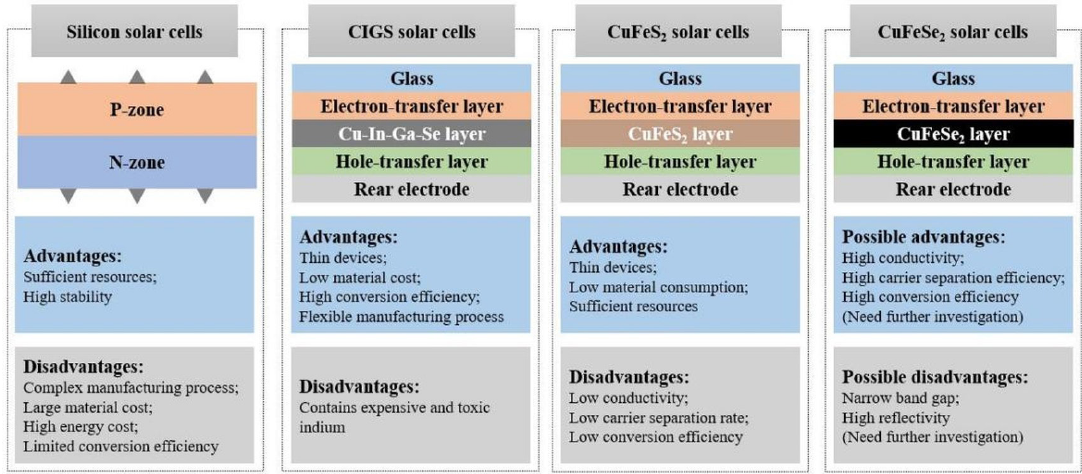
cells and CuFeSe solar cells and the comparison of 2 2